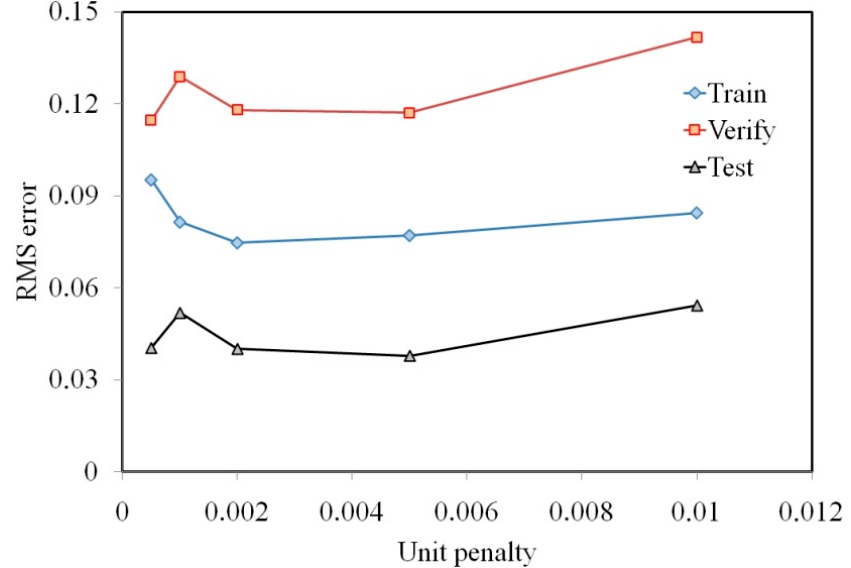
Figure 5. The e ff ect of the unit penalty of the RMS error. Figure 5. The effect of the unit penalty of the RMS error.